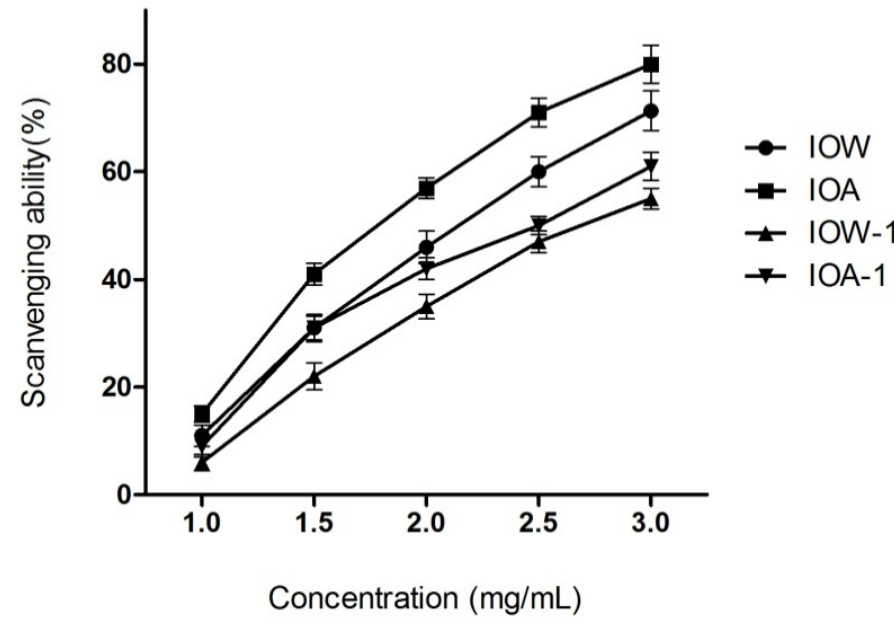
Figure 3. Scavenging ability on superoxide radicals.